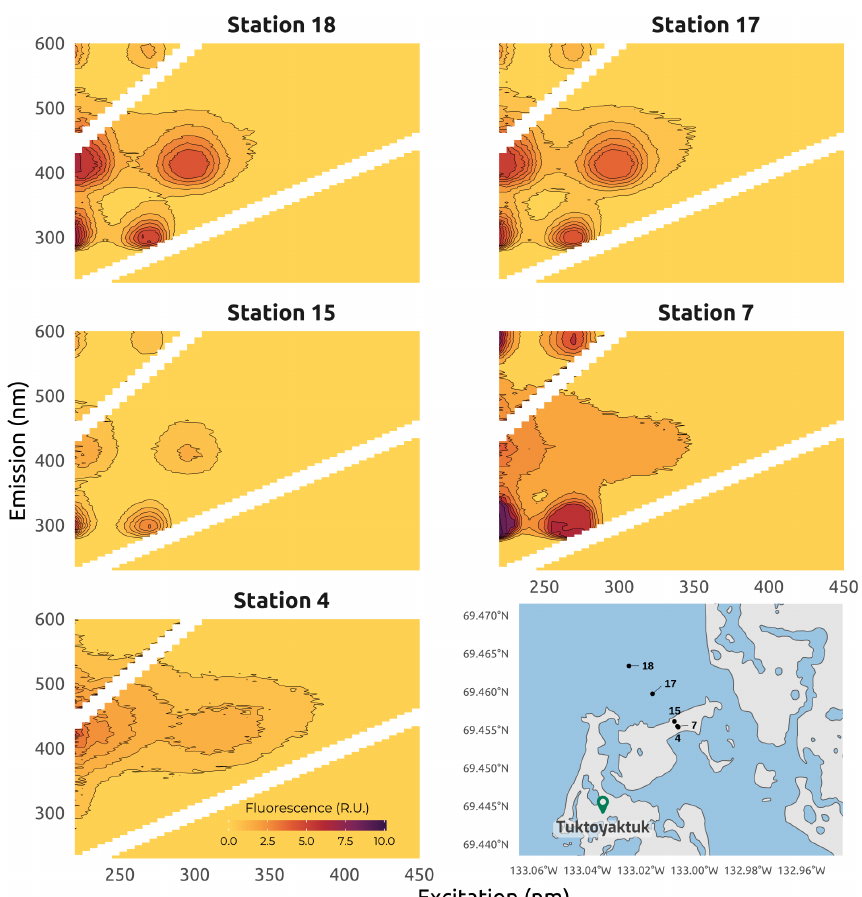
Figure 13. Examples of excitation–emission matrices (EEMs) obtained for seawater samples (stations 15, 17, and 18), beach groundwater (station 7), and thawed permafrost and massive ice (station 4) collected in Tuktoyaktuk Island site during Leg 3 of the 2019 WP4 Nunataryuk field expeditions. EEMs are all corrected for the Raman and Rayleigh scattering and the inner-filter effect. Note that the intensity scale is the same for each sample. The shapefiles for the Tuktoyaktuk area were from https://www.geogratis.gc.ca/ (last access: 3 February